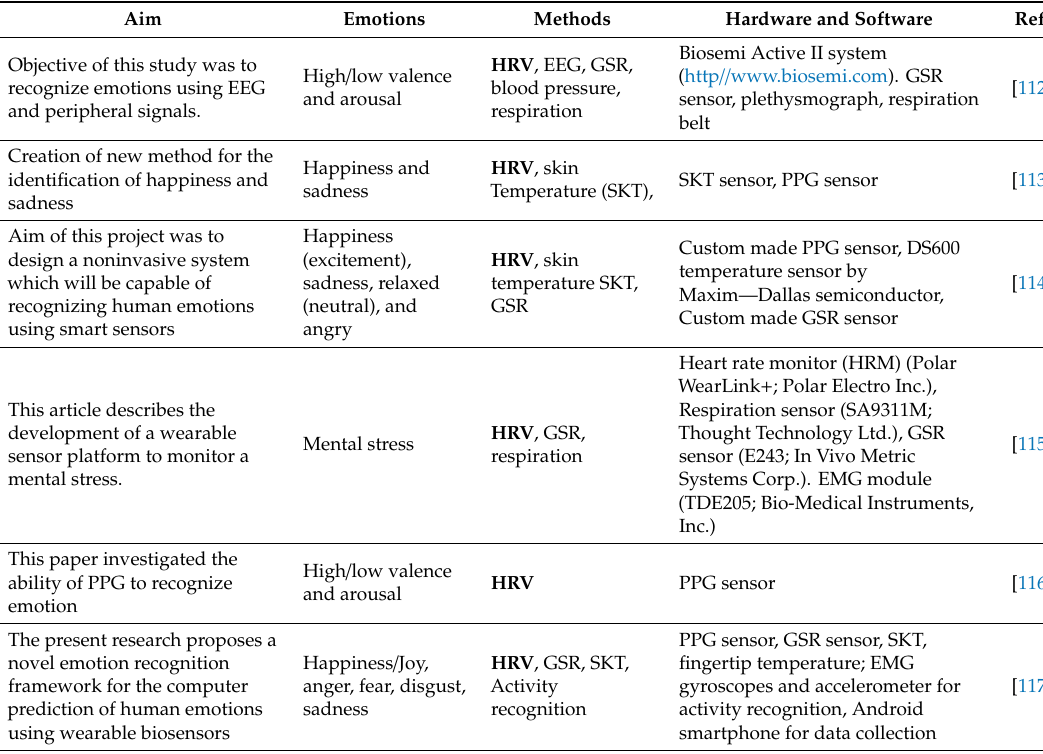
Table 6. Review of scientific researches focused on emotions recognition and evaluation using HRV.